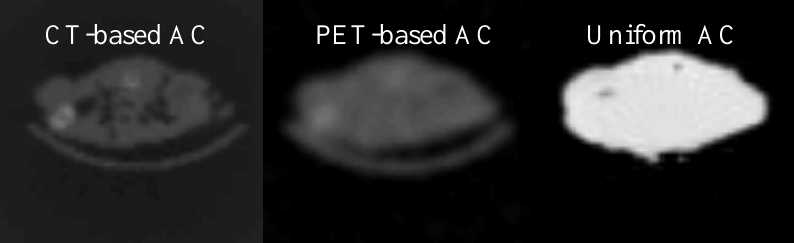
Figure 3. Attenuation map of one mouse using the three different AC methods: CT-based, PET-based and uniform attenuation